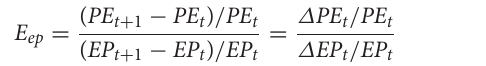
TABLE 1 | Efficiency evaluation index of medical PPP